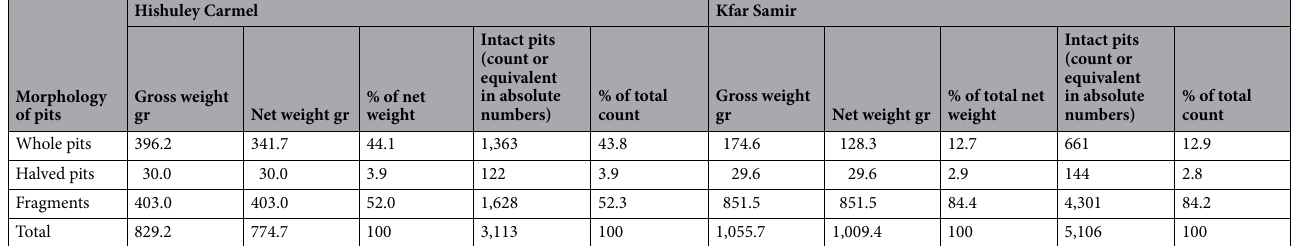
Table 1. Characterization and fragmentation patterns of olive-pit assemblages from Hishuley Carmel and Kfar Samir.